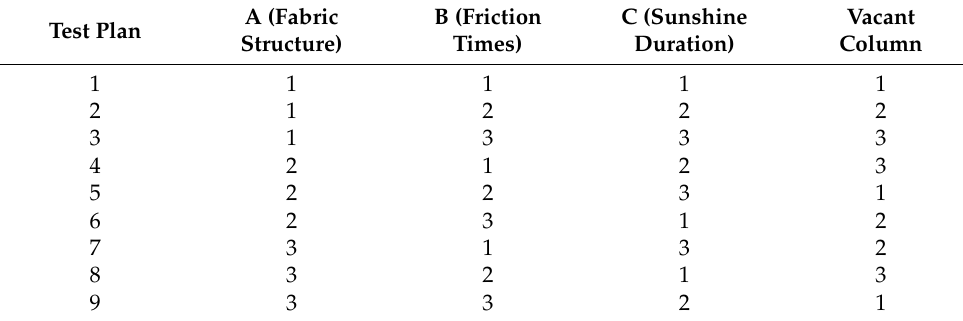
Table 6. Orthogonal experimental